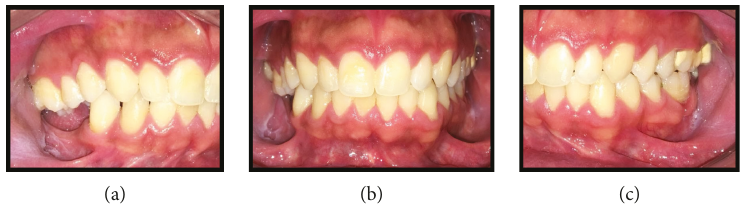
Figure 16: (a), (b), and (c) Intraoral pictures after two years showing stability in the occlusion.